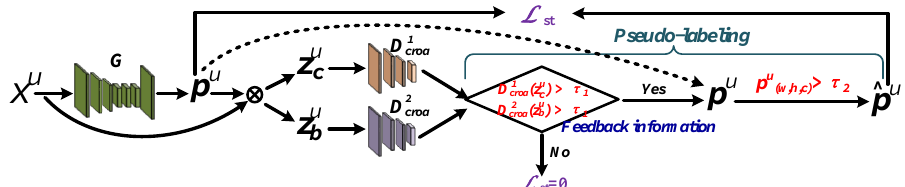
Figure 7. The double threshold pseudo-labelling method for